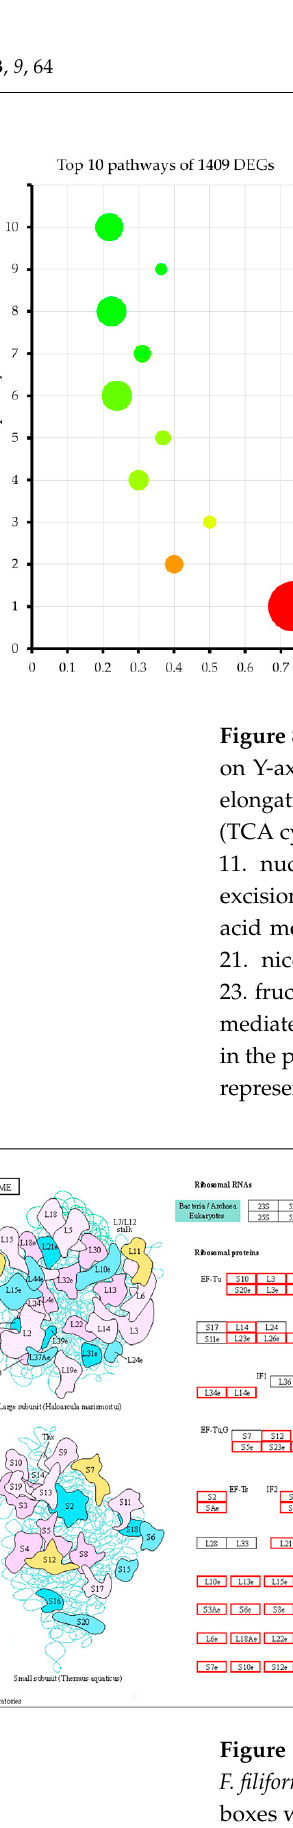
Figure 7. Kyoto Encyclopedia of Genes and Genomes (KEGG) classification of DEGs among differ- ent groups.